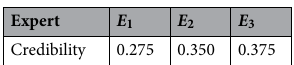
Table 5. The credibility of evidence.